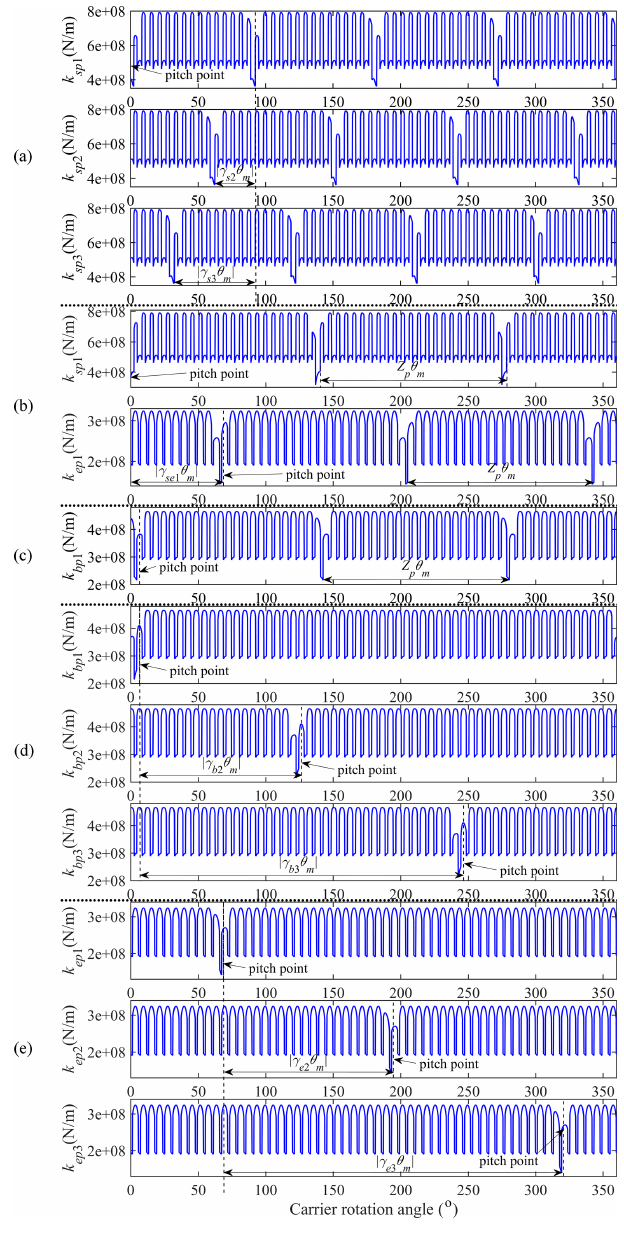
Figure 5. Meshing stiffness curves affected by crack faults: (a) case I; (b) case II; (c) case III; (d) case IV; (e) case